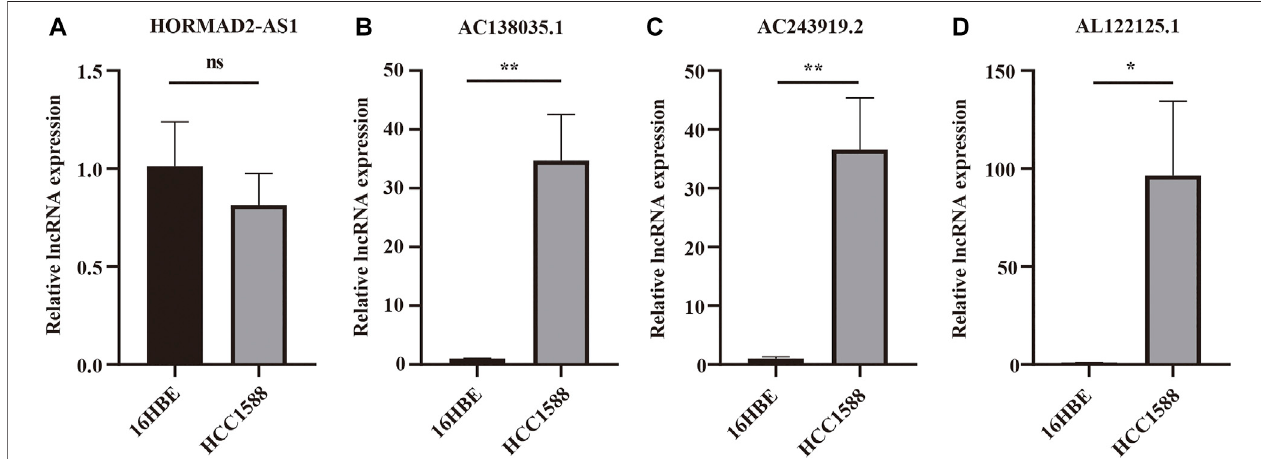
FIGURE 12 | The expression of 4 m 6 A-LPMs in 16HBE cell and HCC1588 cell. (A – D) The expression of HORMAD2-AS1 (A) , AC138035.1 (B) , AC243919.2 (C) , andAL122125.1 (D) in16HBEcellsandHCC1588cellswereveri fi edbyreal-timePCR.m 6 A-LPMs,m 6 A-relatedlncRNAprognosticmarkers.Statisticalmethods: t -test, * p < 0.05, ** p <